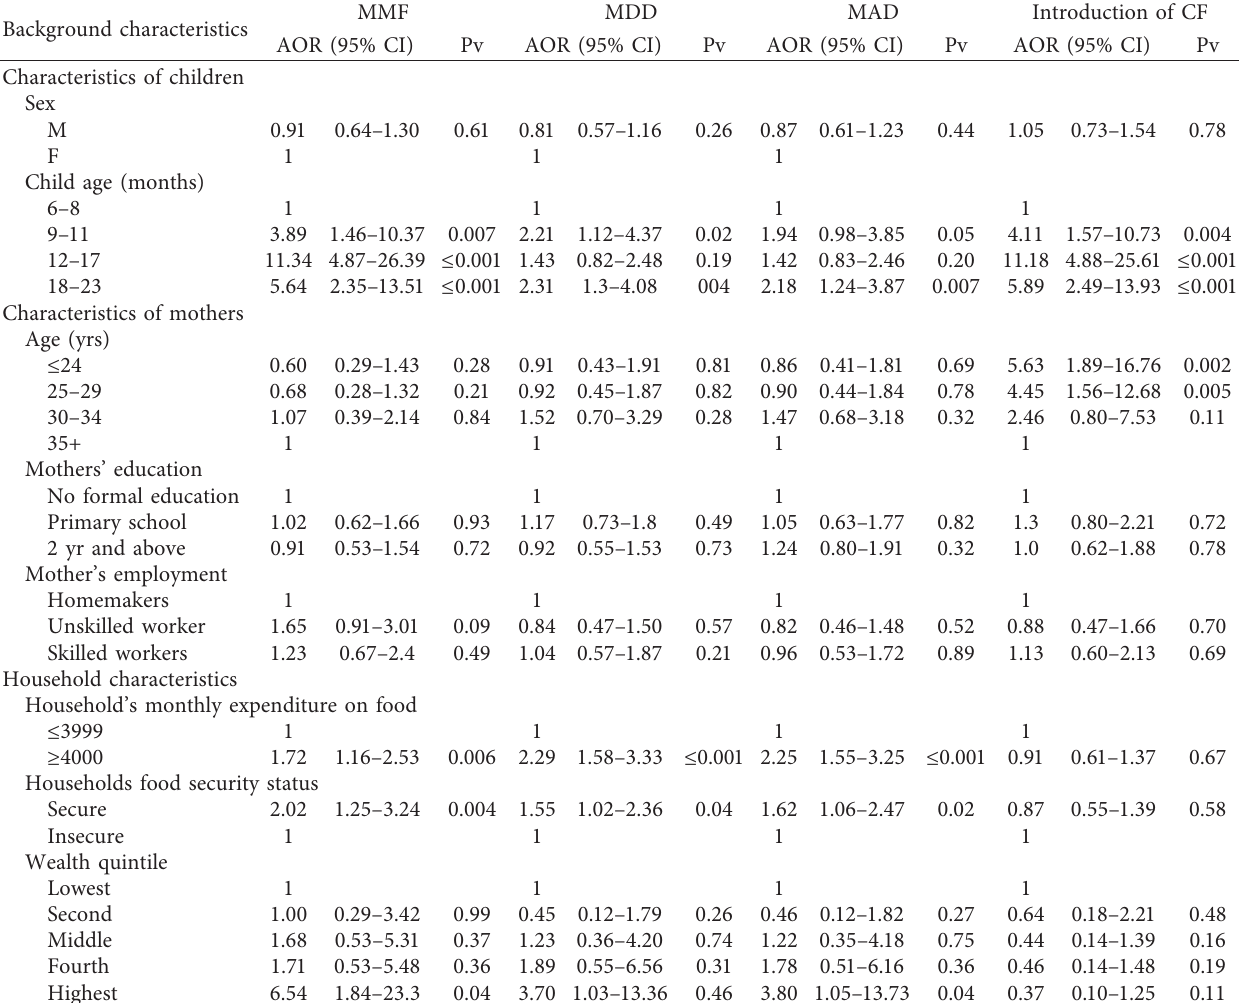
Table 6: Multivariate association of food security status with CF indicators of children aged 6–23 months in Shashemene city, Oromia, Ethiopia,